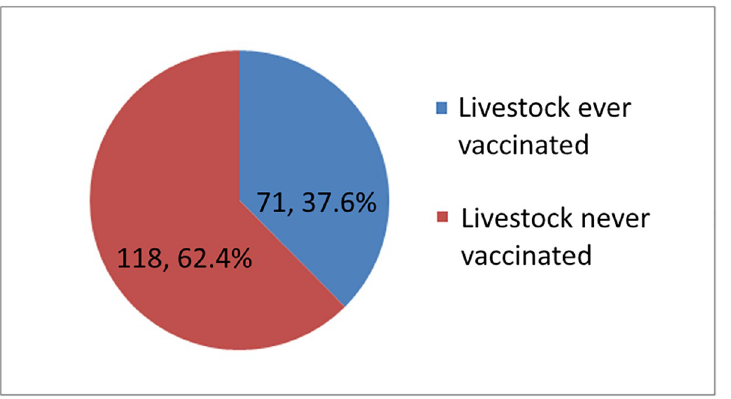
Fig 3. Number of respondents that vaccinated livestock at any time.